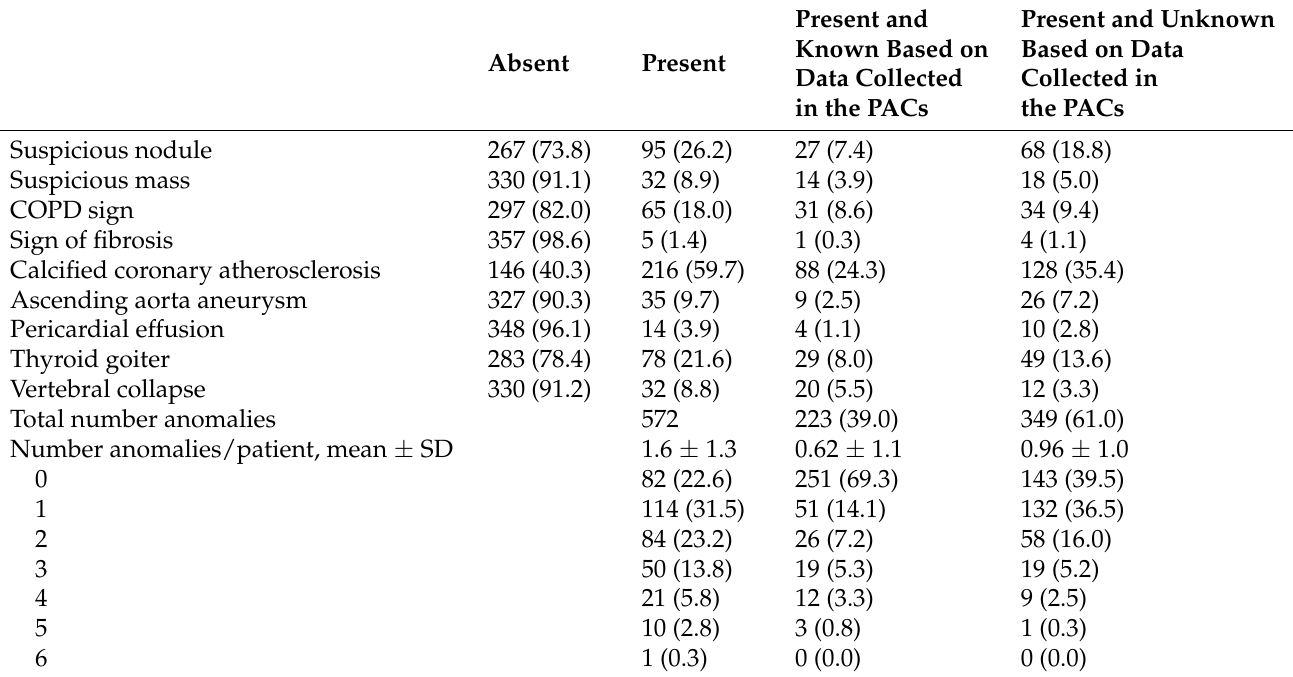
Table 3. Abnormalities identified in CT scan (N = 362